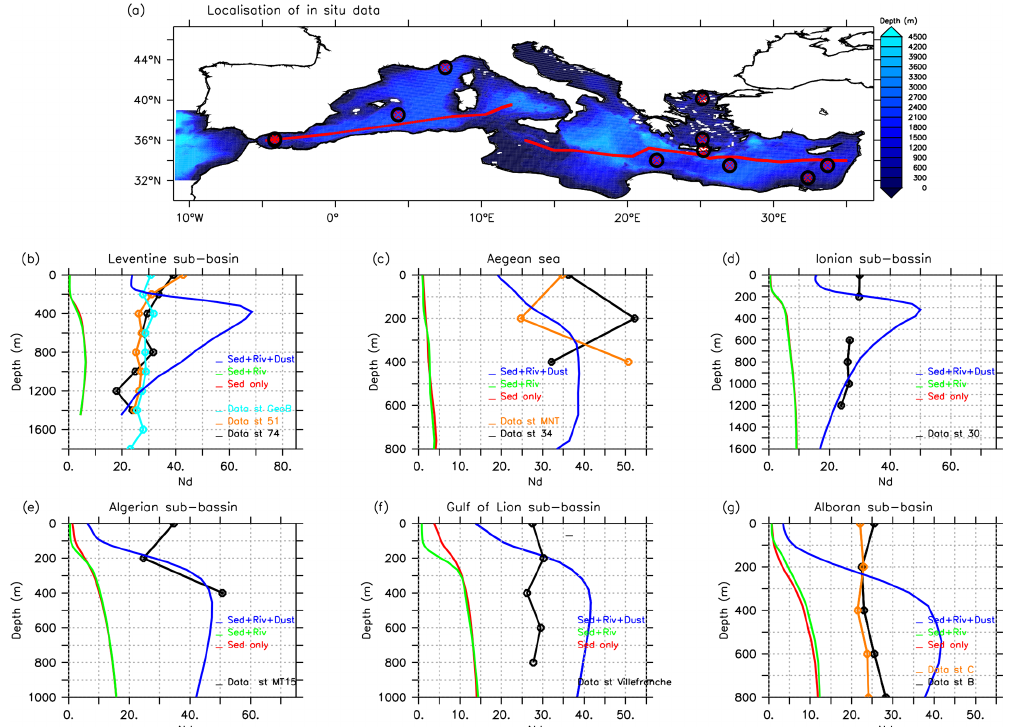
Figure A7. (a) Map of the NEMO-MED12 model domain and bathymetry with location of the main Mediterranean sub-basins and in situ observation. The solid lines (in red) represent the trans-Mediterranean vertical section. Comparison of the vertical profiles of [Nd] (in pmolkg − 1 ) between in situ data and model output for Levantine (b) , Aegean (c) , Ionian (d) , Algerian (e) , Gulf of Lion (f) , and Alboran